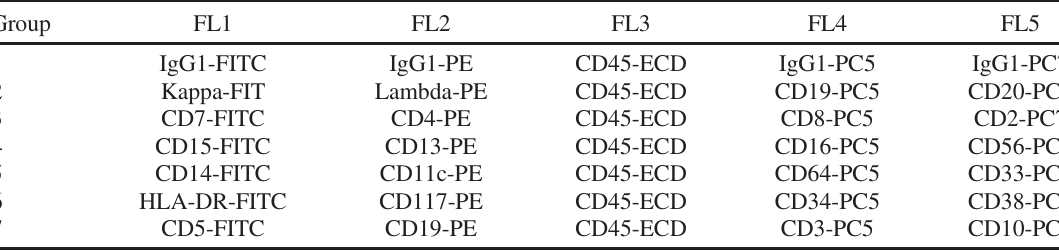
TABLE I. List of the five specific fluorescent markers, denoted by FL1, FL2, FL3, FL4, and FL5, used in each of the seven groups of measurements.